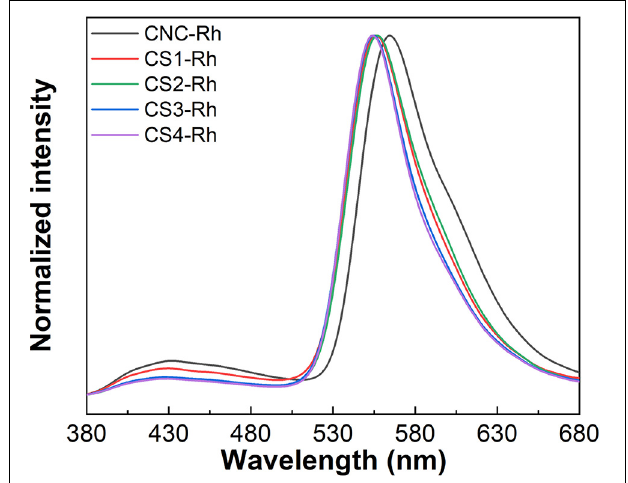
FIGURE 5 | Emission spectra of CNC/silica composite films doped with Rh6G under excitation at 348 nm.